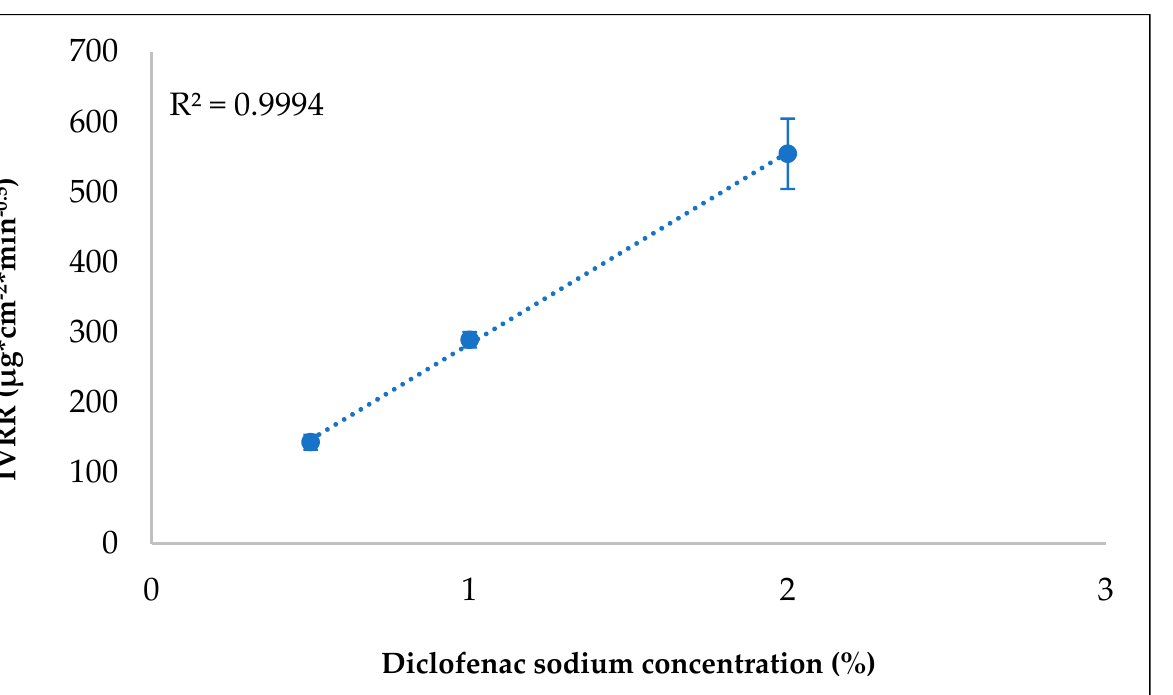
Figure 5. Specificity of the in vitro release test (IVRT).